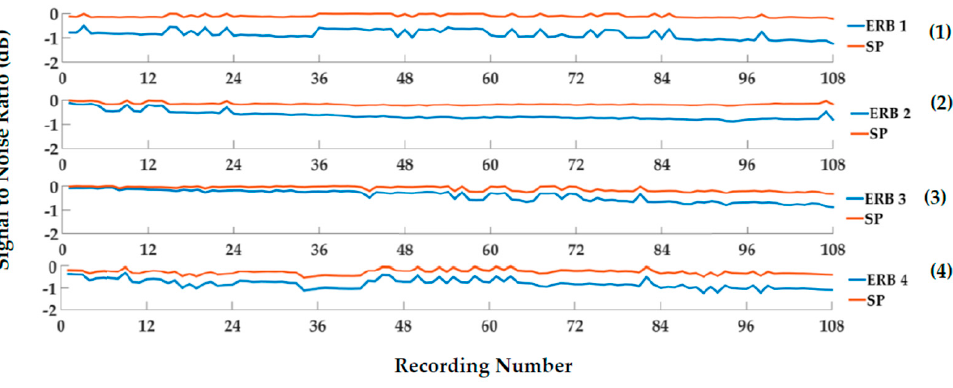
Figure 5. Signal to noise ratio of the ERBs and the SP. ( 1 ) to ( 4 ) refer to different ERBs.